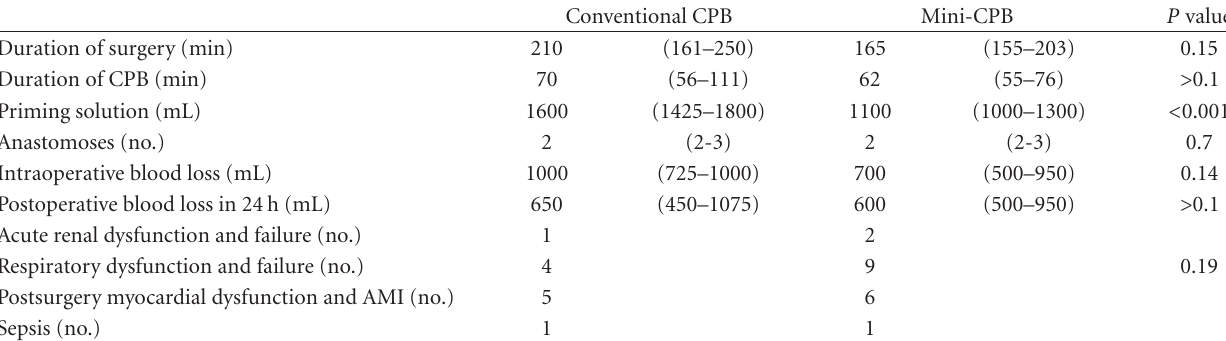
Table 3: Intraoperative and postoperative data of patients.